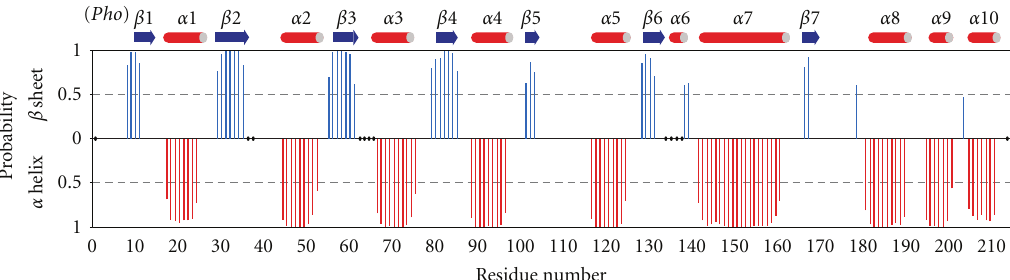
Figure 4: Chemical-shift-based secondary structure prediction of free RPP30 is consistent with its structural homology to Pho RPP30. Graph shows probability for each residue assigned to be either β sheet (blue above axis) or α helix (red below axis), as determined with the TALOS+ software [19]. Assigned secondary structure is given to each residue based on the highest probability for the residue to be either α Helix, β Sheet, or Loop. Loop residues are not indicated, while dots on the x -axis represent residues for which TALOS+ gave no prediction. For comparison, the secondary structure observed in crystals of the homologous Pho RPP30 is shown above the graph.